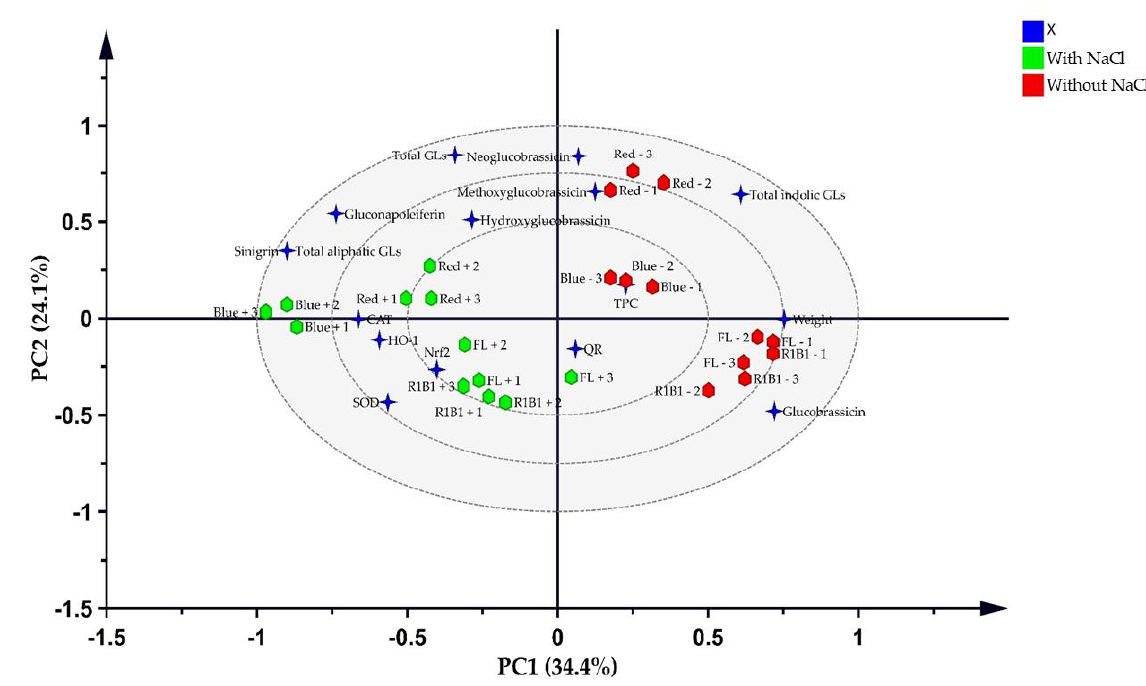
Figure 6. Partial least squares discriminant analysis (PLS-DA) score plots of variables and the treatment groups. The blue stars represent the variable and the green hexagons represent extracts from microgreens grown in the presence of salt stress while red hexagons are extracts from microgreens grown in absence of salt stress.